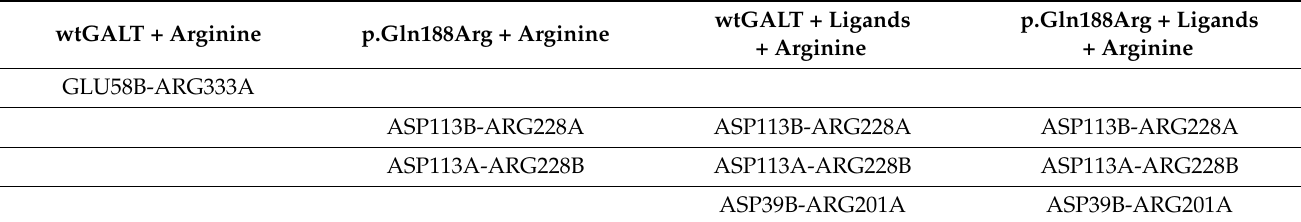
Table 5. Couples of residues involved in stable intersubunit salt bridges in simulations with arginine in the central cavity. Couples of residues are considered to have a stable salt bridge interaction when the sum of % of existence of the salt bridges between the two residues is ≥